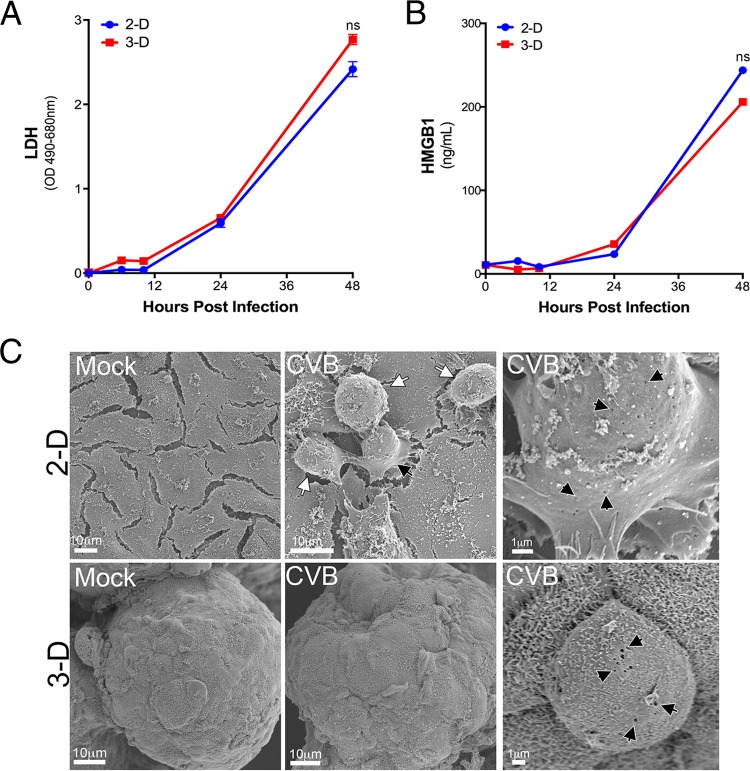
(A) Levels of released LDH in 2-D or 3-D cultures of Caco-2 cells infected with CVB (1 PFU/cell) for the indicated times postinfection. OD 490-680 nm, optical density at 490 to 690 nm. (B) Levels of HMGB1 (in nanograms per milliliter) in the supernatants of 2-D or 3-D cultures of Caco-2 cells infected with CVB (1 PFU/cell) for the indicated times. Values that are not significantly different (ns) as determined by a Student’s t test are indicated. (C) Scanning electron micrographs of 2-D or 3-D cultures of Caco-2 cells. Mock-infected controls and cultures infected with CVB for 24 h are shown. (Right) Zoomed-in images of single infected cells with black arrowheads denoting membrane lesions.